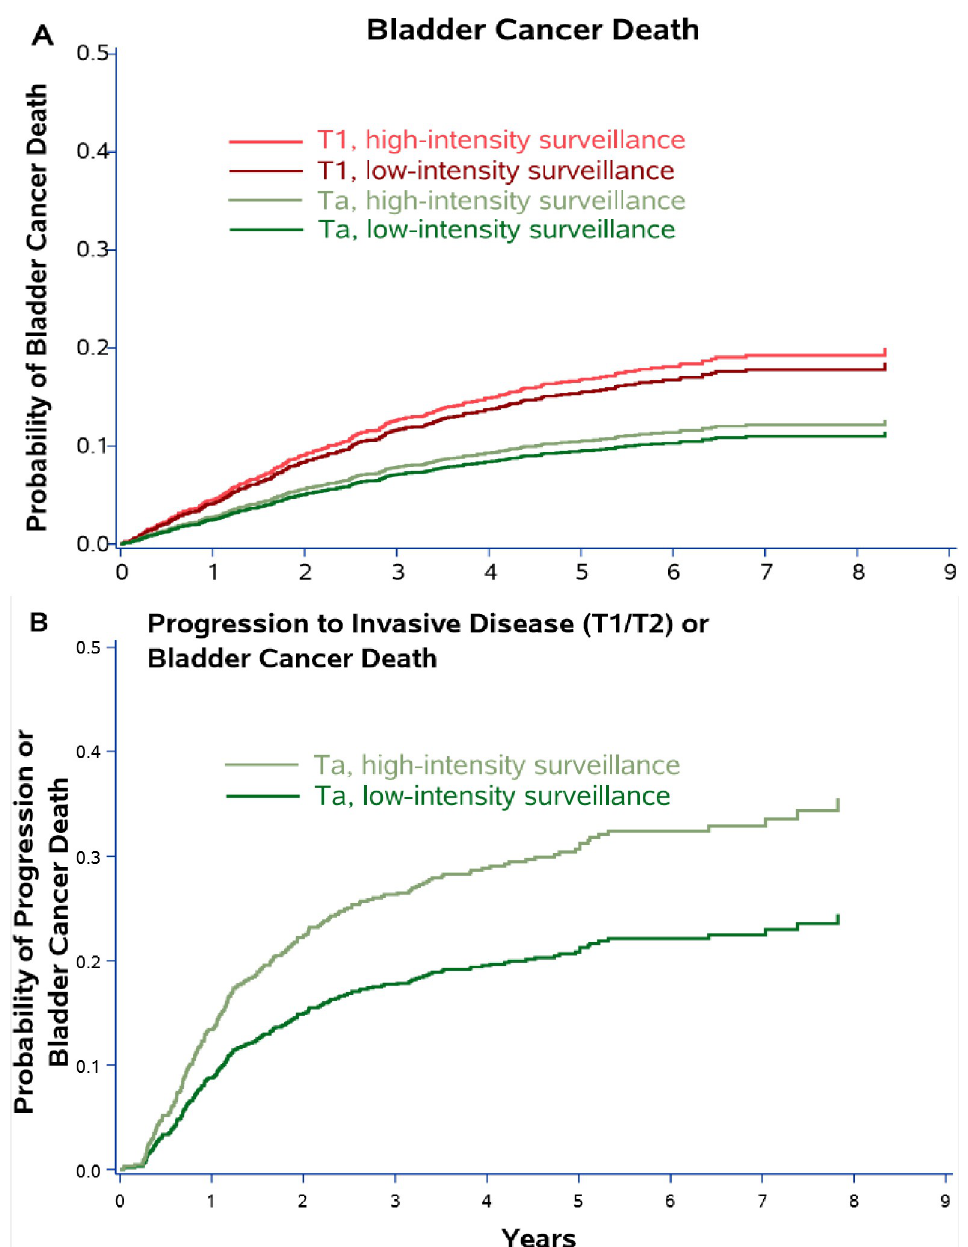
Fig 2. Sensitivity analyses, now including any patients who died or had their last contact with the VA health system during the first two years after diagnosis. Cumulative incidence plots showing the probability of 1) bladder cancer death by Ta versus T1 disease and by cystoscopic surveillance intensity (Panel A) and 2) progression to invasive disease (T1 or T2) or bladder cancer death among those with Ta disease (Panel B). Data are from Fine and Gray competing risk models adjusted for propensity score and receipt of intravesical therapy with death from other causes modeled as a competing